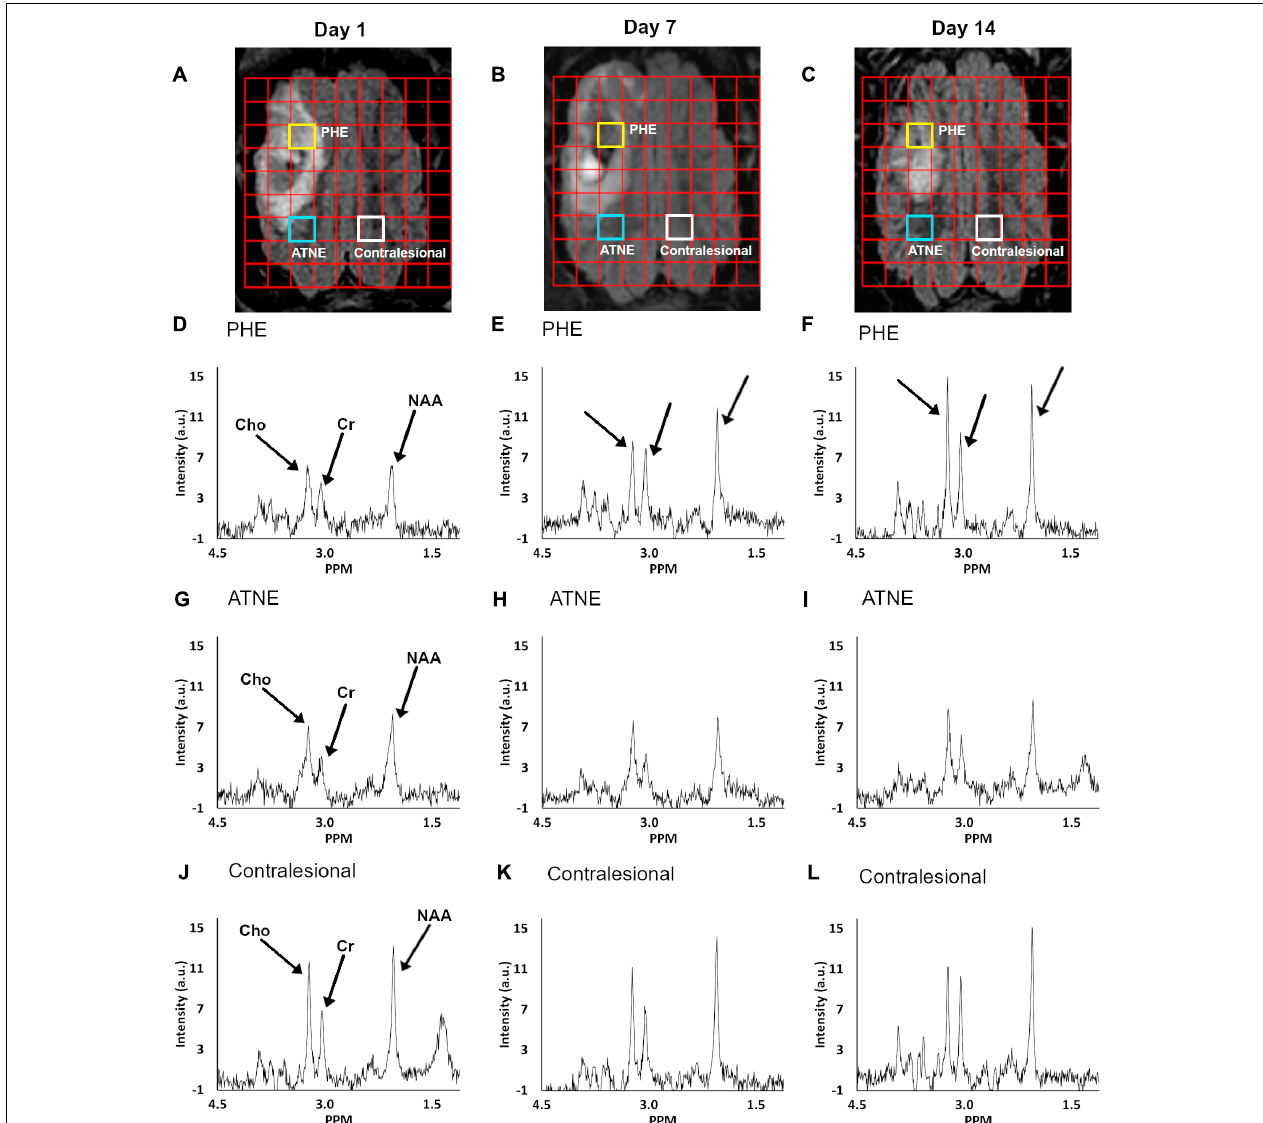
FIGURE 2 | Serial FLAIR MRI images overlaid with a multi-voxel grid of corresponding temporal spectra with highlighted voxels of interest (A–C) . Panels (A–C) show the PHE, ATNE, and contralesional voxel location at day 1, 7, and 14, respectively, from which the metabolite spectra were measured. MR spectroscopy graphs at days 1, 7, and 14 (columns) are shown for voxels from the PHE (D–F) , ATNE (G–I) , and the contralesional regions (J–L)